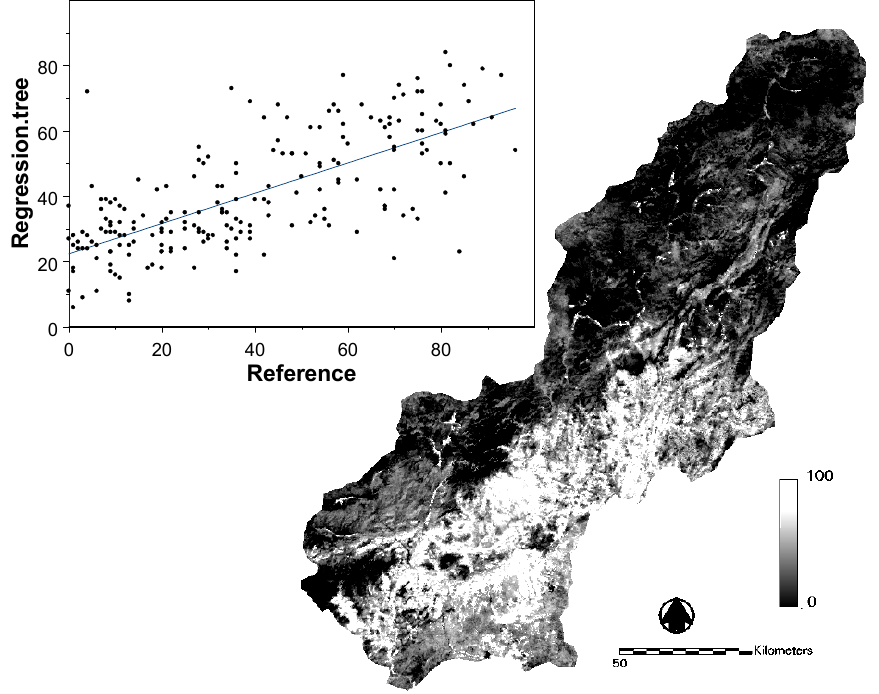
Figure 5. Predictions of percentage tree cover based on the regression tree (RT) model, and comparison of predicted versus observed tree cover ( R 2 = 50.4%; n = 209